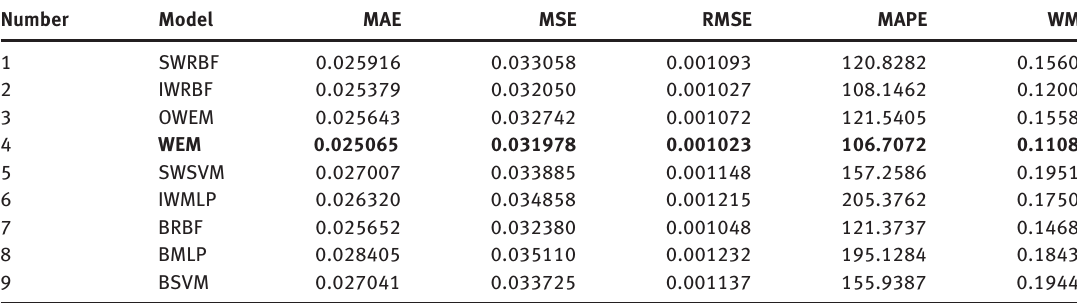
Table 3. Experiment Result and